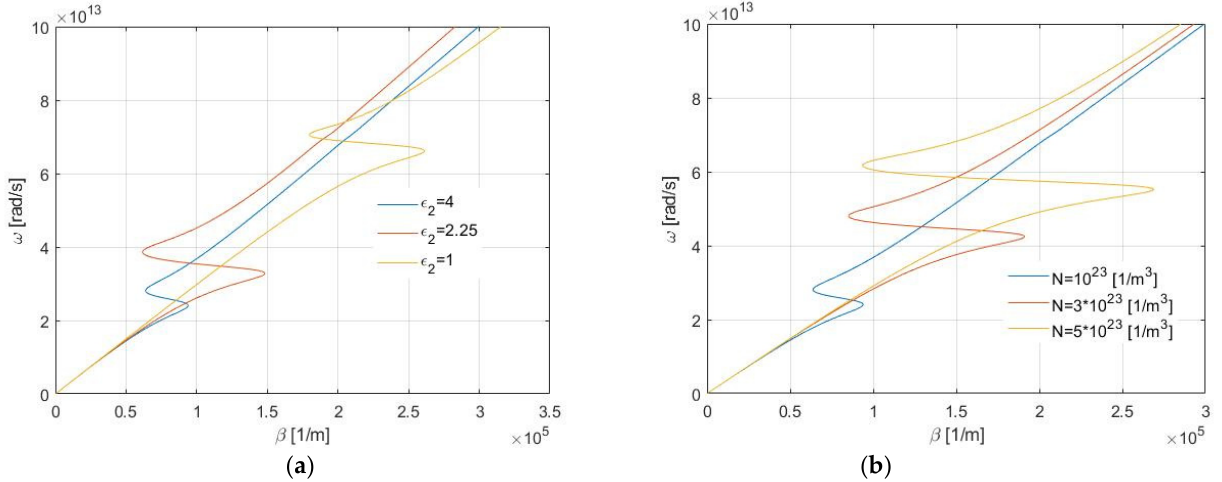
Figure 5. Dispersion maps of the surface plasmon polaritons propagating at the boundary of semiconductor-based metamaterial: ( a ) dielectric tunable dispersion; ( b ) concentration tunable dispersion.